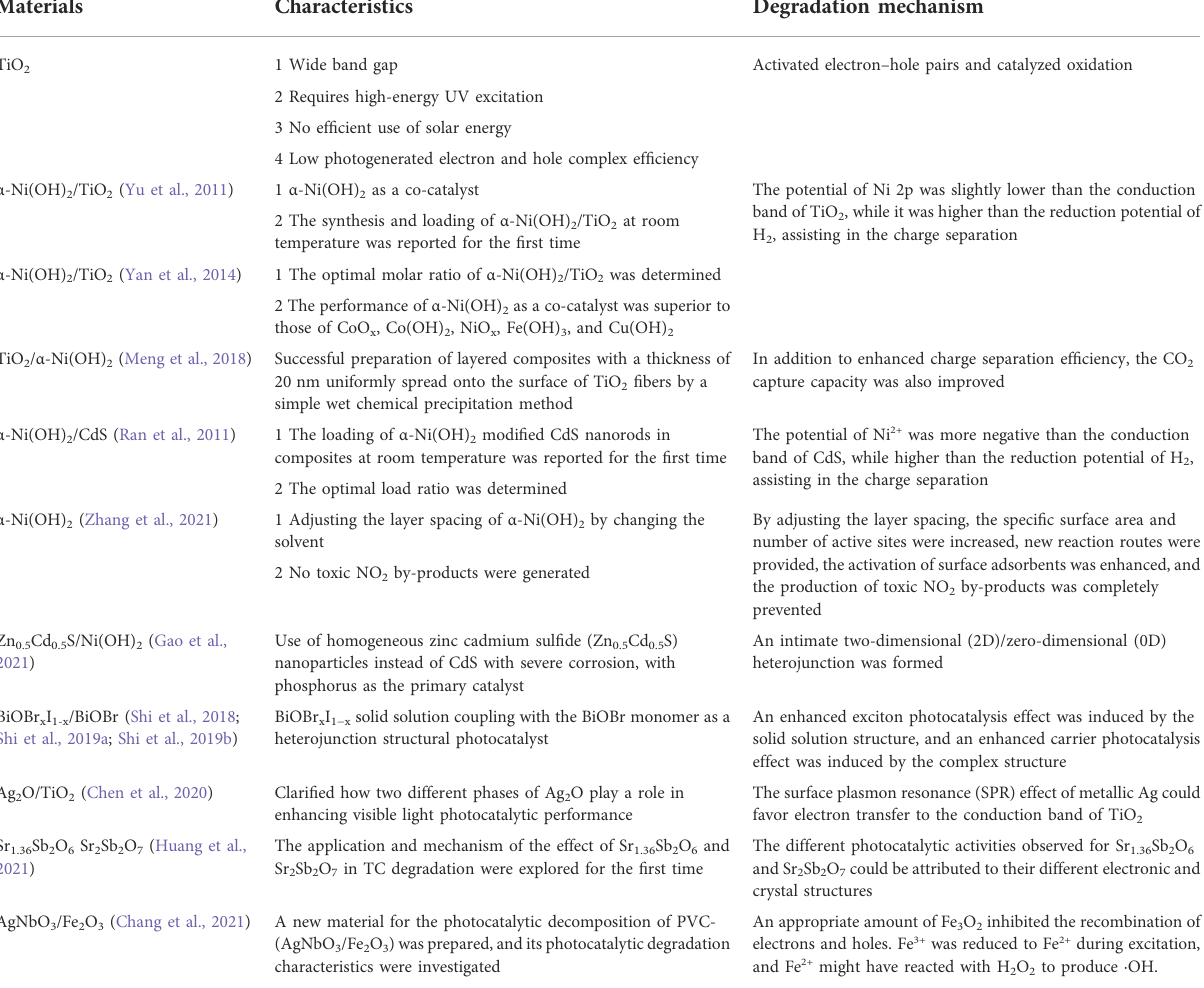
TABLE 1 The characteristics of similar reported